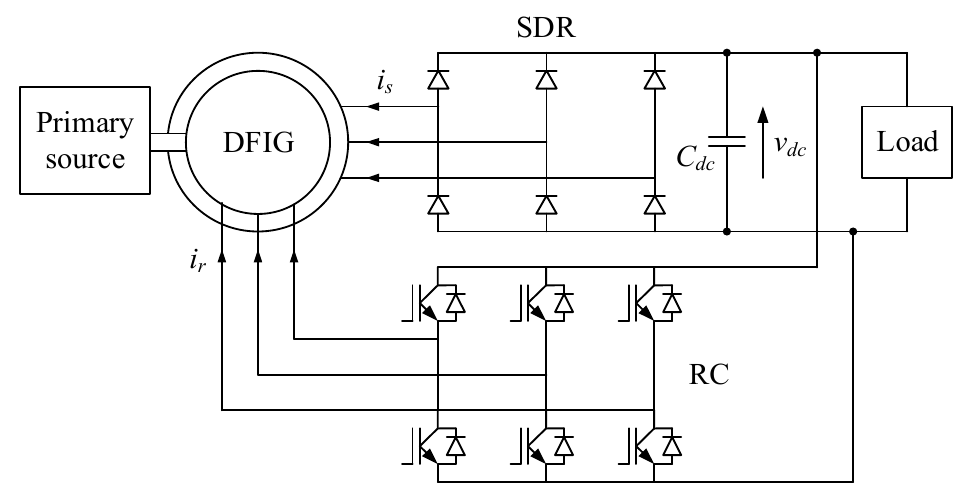
Figure 1. Scheme of the analyzed stand-alone DFIM-based DC voltage generator. Torque oscillations can be cancelled using different manners and methods of